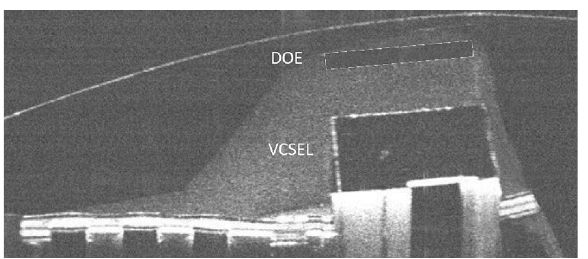
Figure 10. OCT view of the circuit inside the contact lens with a schematic representation of the DOE.